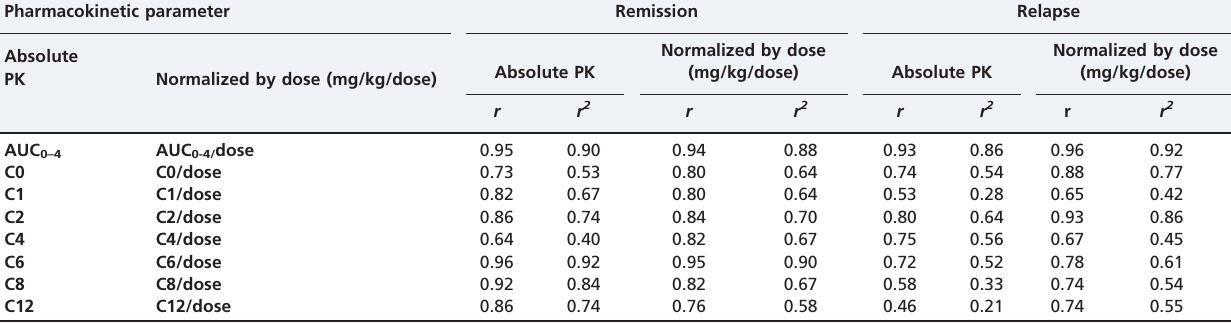
Table 4 - Correlation between all pharmacokinetic parameters and AUC 0-4 with AUC 0-12 during remission and relapse of the nephrotic syndrome, expressed as absolute values or normalized by dose